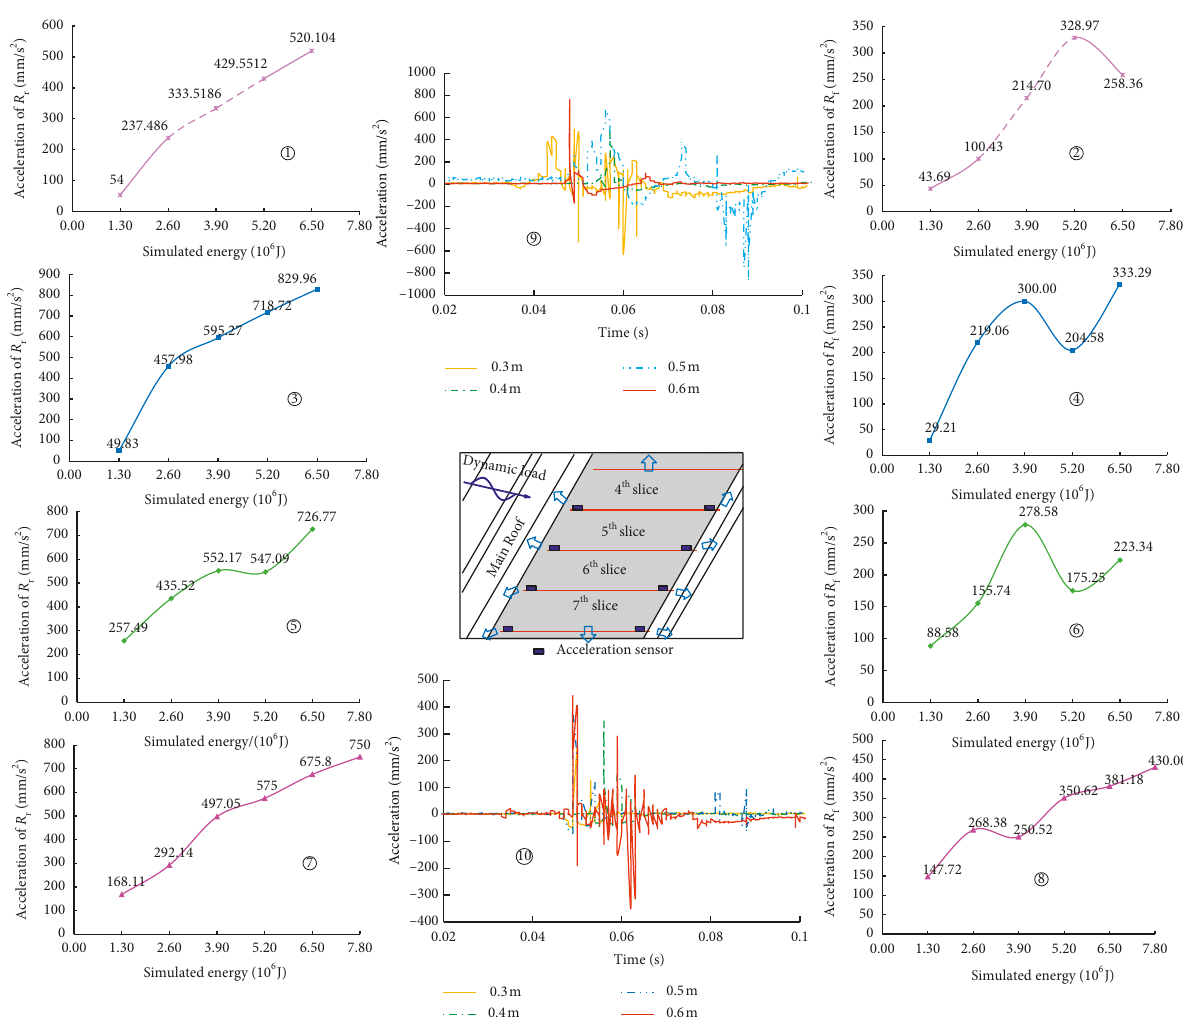
Figure 9: Characteristic curves of acceleration